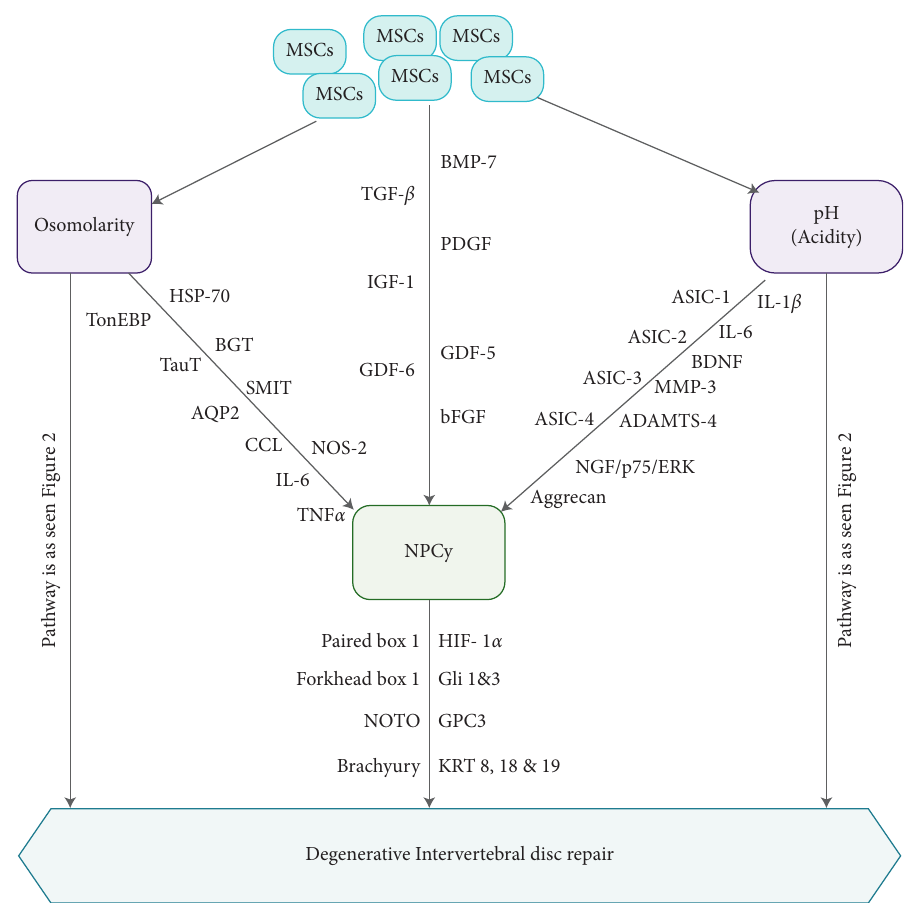
Figure 1: Illustration showing the pathway via which MSCs influence NPCy at the microenvironment leading to repair of IVDD. Factors such as TGF- β , GDF-5 and 6, BMP-7, PDGF, IGF-1, and β FGF are responsible for the differentiation of MSCs towards NPC-like cells. Also, acidity and osmolarity via diverse signaling pathways are key factors influencing the MSCs/NPC